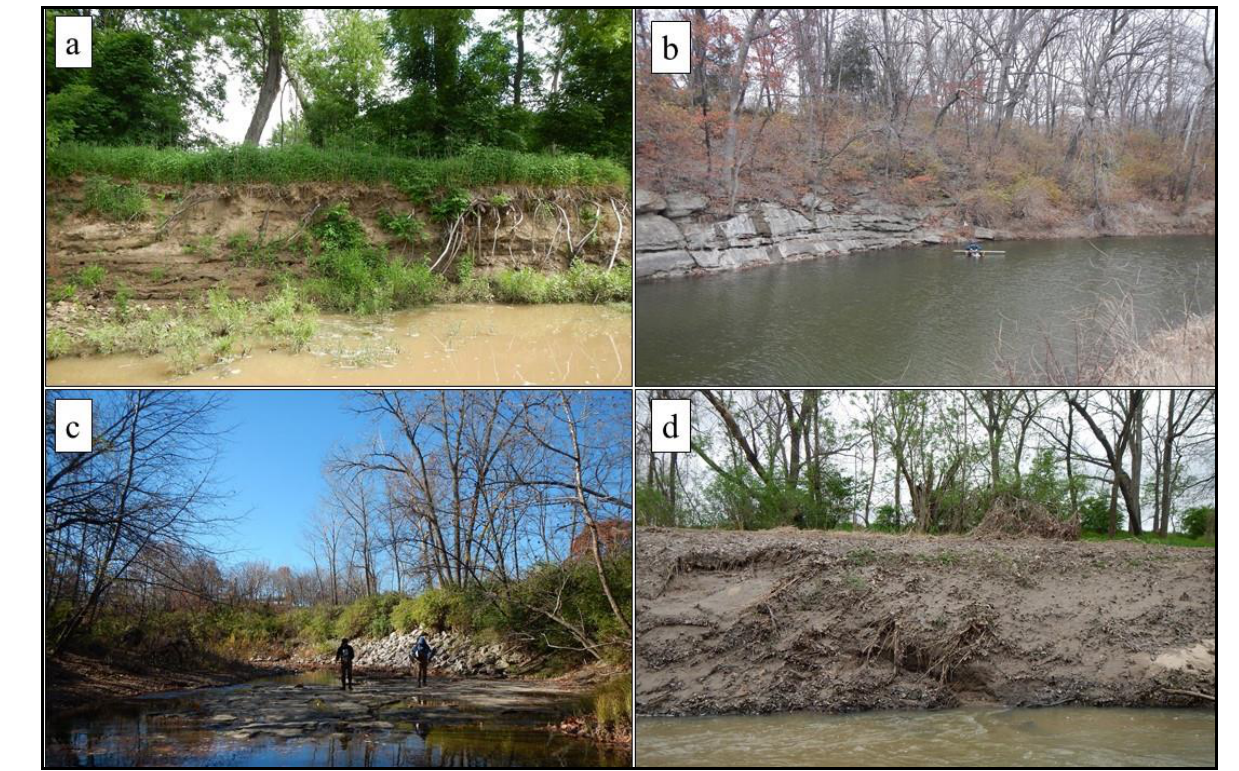
Figure 3. Examples of channel characteristics associated with the agricultural headwaters ( a ), rural-urban mid-reaches ( b , c ), and lower urban reaches ( d ) of Hinkson Creek Watershed, USA.